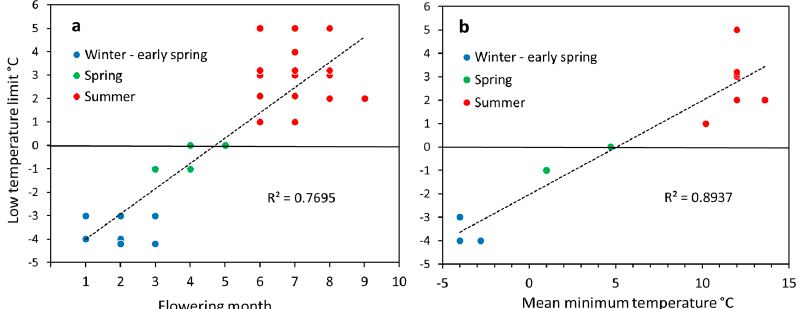
Figure 1. Relationship between low temperature limit of pollen germination (i.e., germination is zero or nearly zero) and ( a ) the flowering month and ( b ) the mean minimum air temperature in the coldest month of flowering. Symbols in ( a ) represent the temperature limits for the species flowering in the respective months. Dotted line: linear regression line.